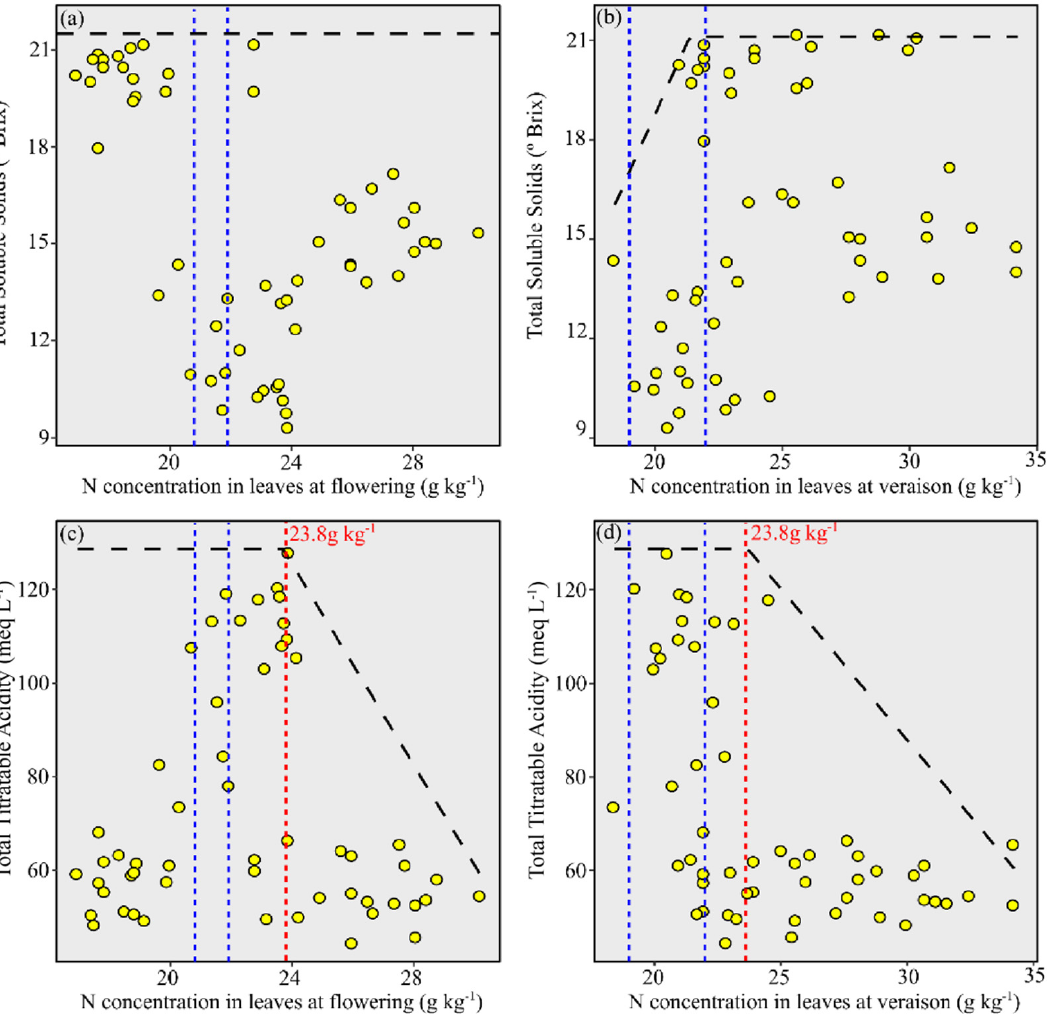
Figure 5. Relationship between N concentration in leaves at flowering and veraison and the total soluble solids ( a , b ), and the total titratable acidity ( c , d ) of ‘Chardonnay’ grape must during 2016/17, 2017/18, and 2018/19. Blue dashed lines represent the proposed N sufficiency ranges based on maximum grape yield.